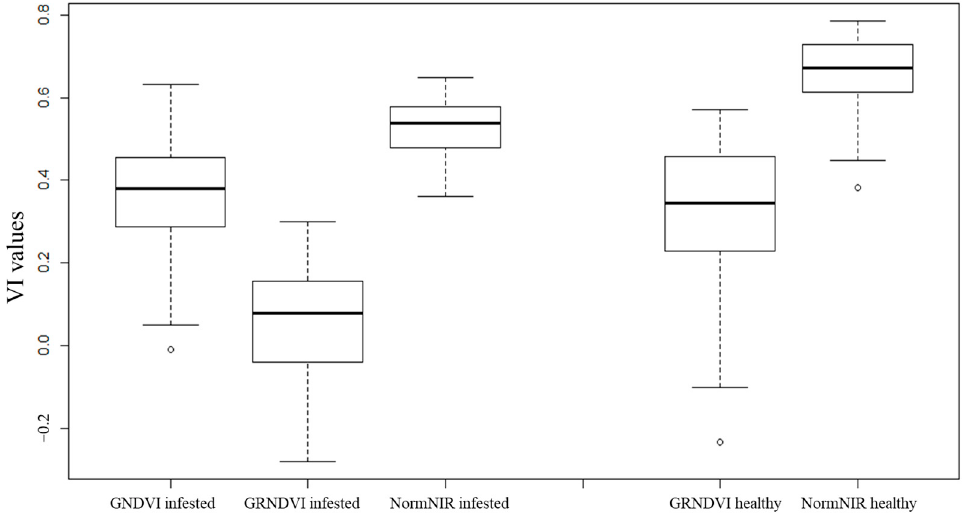
Figure 4. Box-plot for GRNDVI and NormNIR values in the greenhouse and farm field, that showed statistically significant difference by t -test ( p < 0.05).